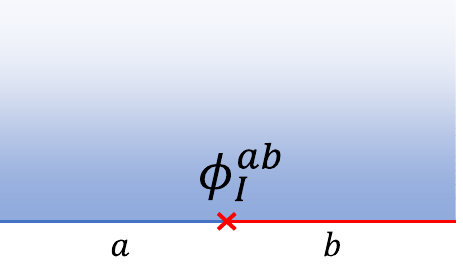
Figure 2 . The definition of the boundary operator. The index I labels a primary field with the conformal dimension h and the indices a, b denote its boundary conditions, where the boundary I condition a is changed to b by the operator φ ab I